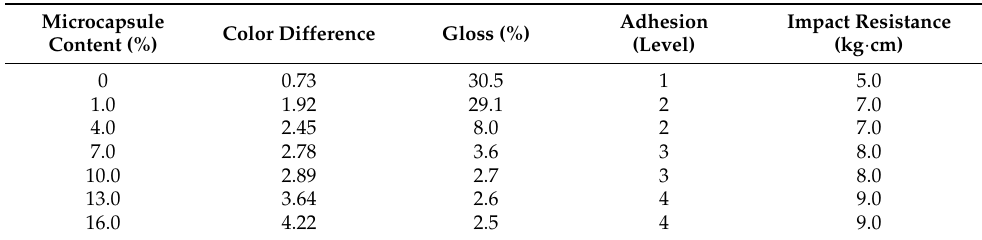
Table 3. Performance of primer film added with different concentrations of urea formaldehyde resin-coated nano-silver solution microcapsules.